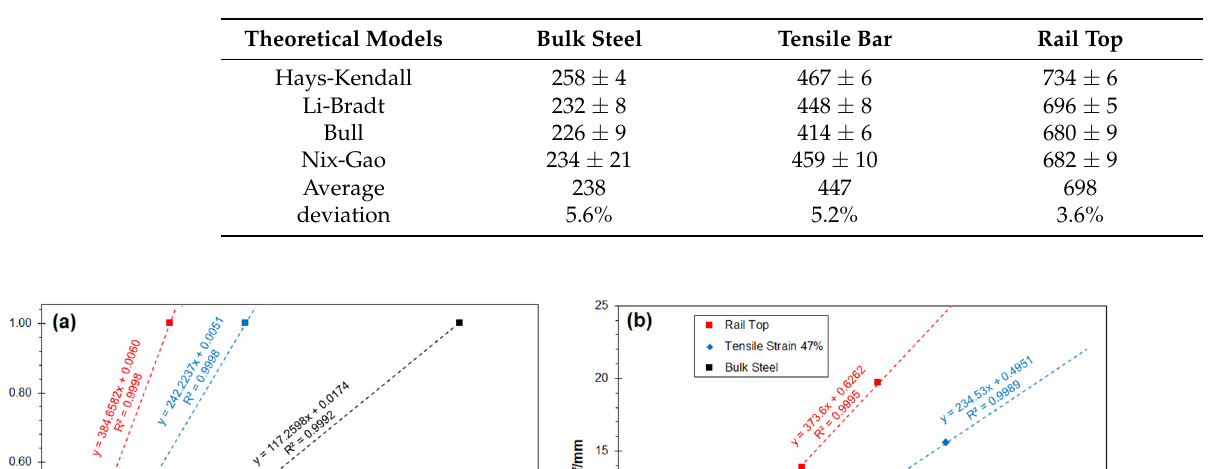
Table 4. Determination of the real hardness of the strained Hadfield steel using indentation loads from 0.01 to 0.2 kgf.